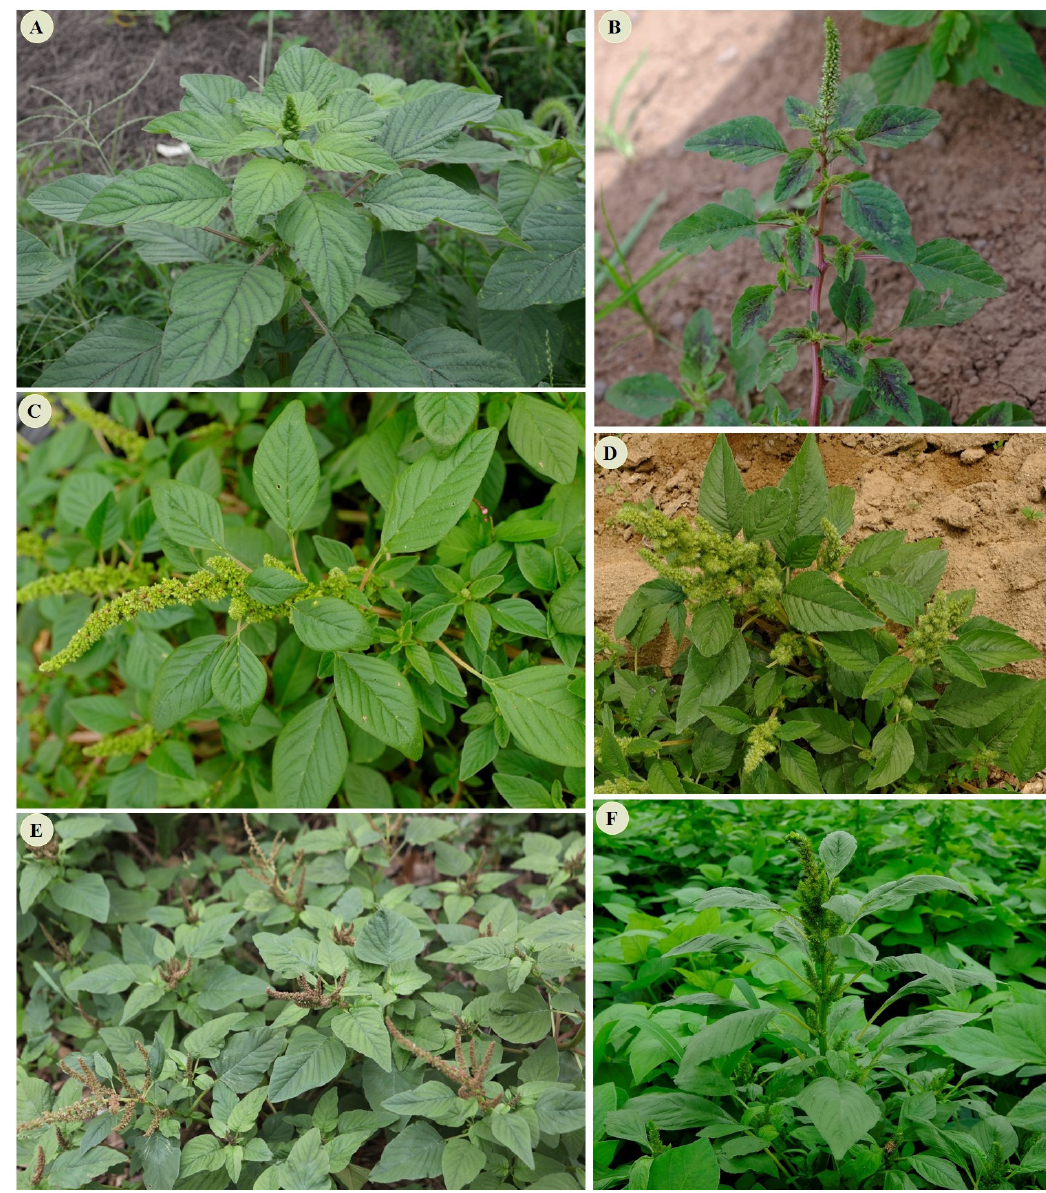
Figure 1. Morphological representation of the leaves of all the species tested in the field. ( A ): Amaranthus patulus Bertol.; ( B ), Amaranthus spinosus L.; ( C ), Amaranthus lividus L.; ( D ), Amaranthus viridis L.; ( E ), Amaranthus retroflexus L.; ( F ), Amaranthus powellii S. Watson. Figures were captured in different geographical locations where the analysis has been done (Table 1).